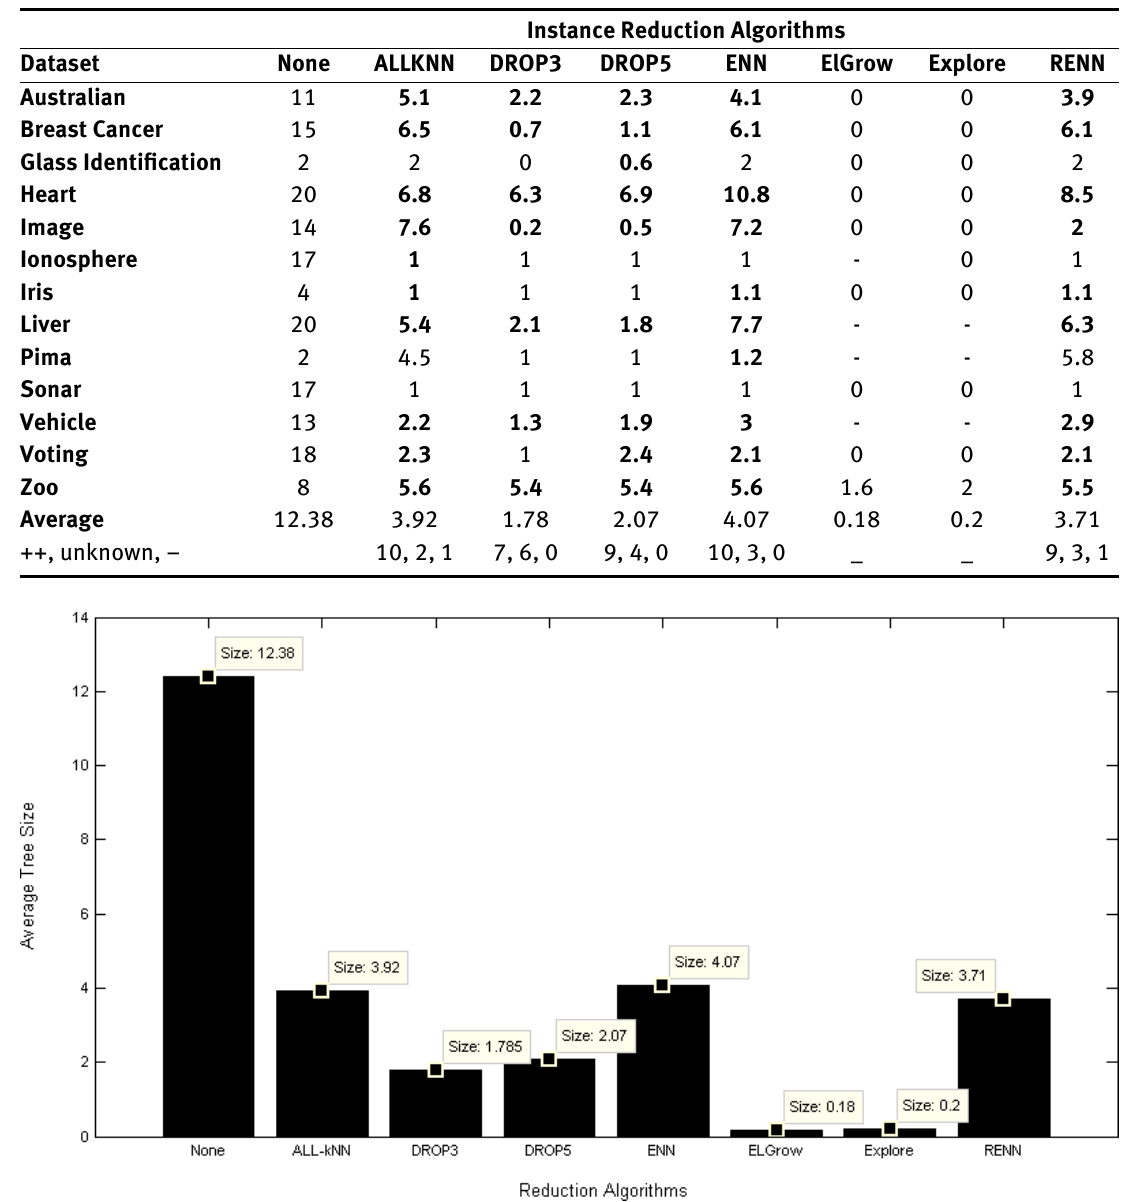
Table 4: Tree Size (Number of Nodes) for unpruned trees With 0% noise ratio